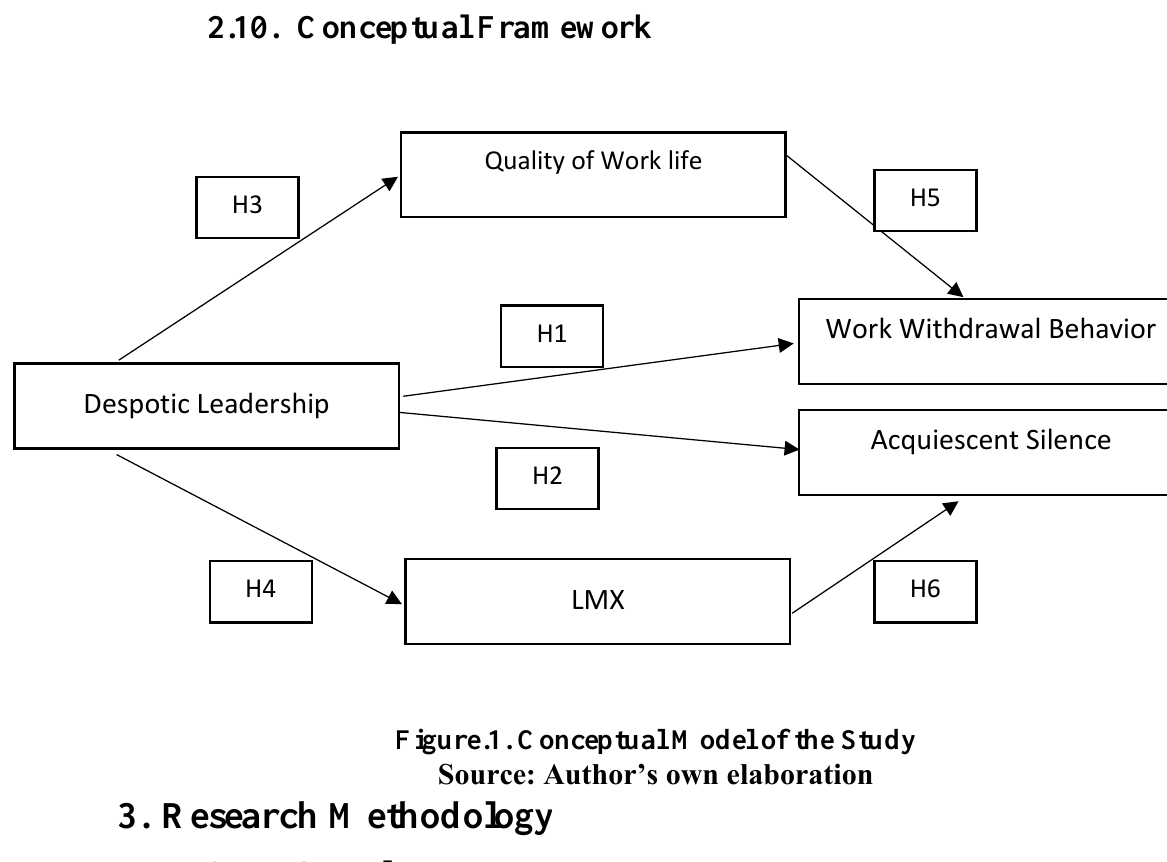
Figure.1. Conceptual Model of the Study Source: Author’s own